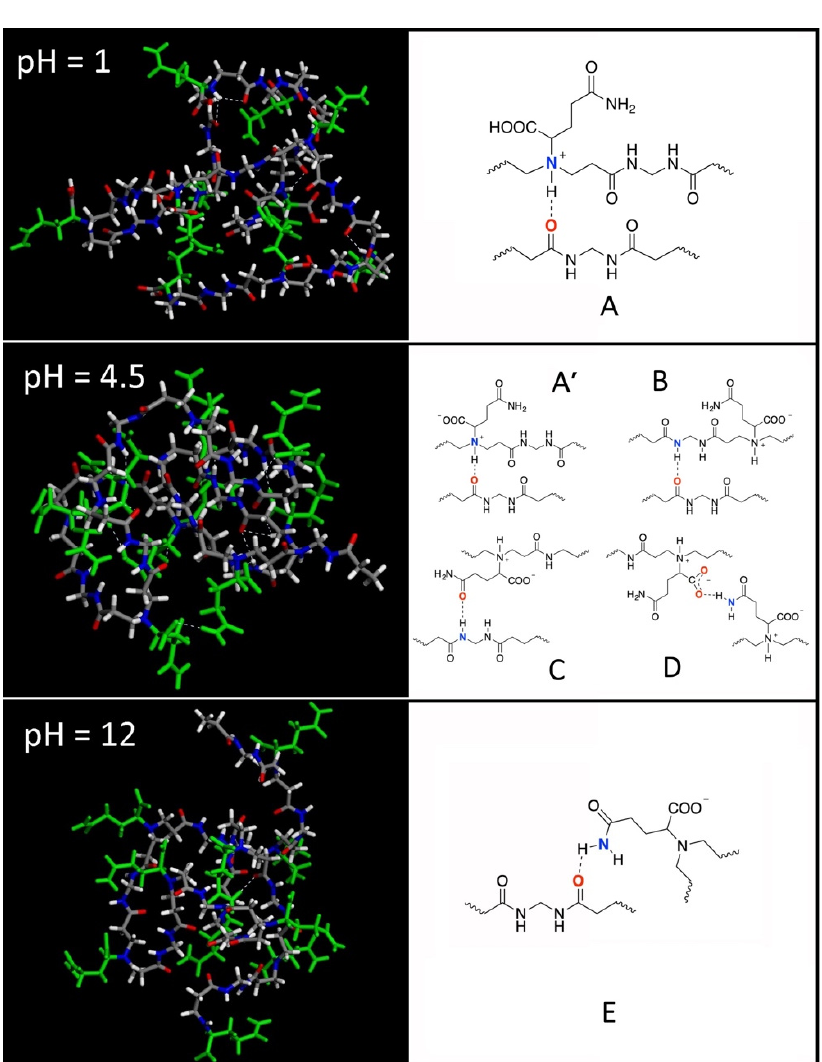
Figure 6. Molecular conformations of M- L -Gln at pH 1.0, 4.5 and 12.0, corresponding to the optimized geometries achieved after the MD runs in water. H-bonds are represented by white, dotted lines. All atoms of the L -glutamine residues are colored in green, whereas the main chain atoms are colored using the same code as in Figure 5. The structures ( A ), ( A' ). ( B ), ( C ), ( D ) and ( E ) are line drawings showing the corresponding intramolecular H-bond patterns (see text).